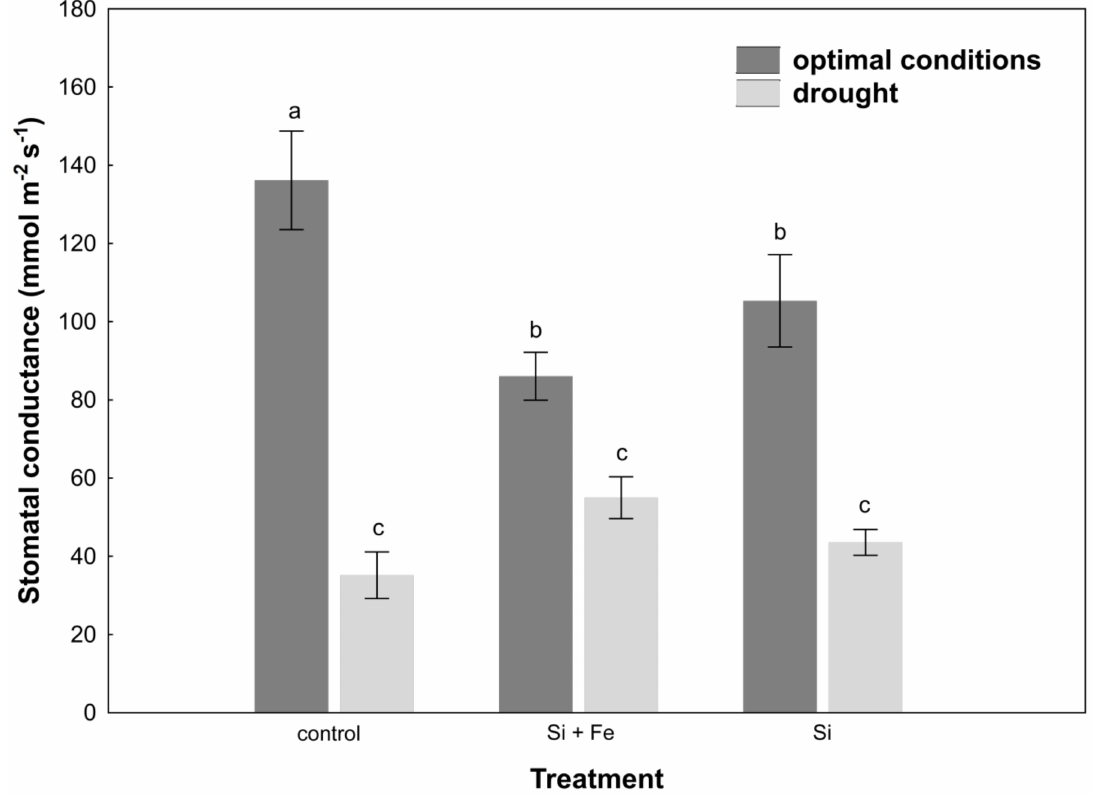
Figure 3. Stomatal conductance in leaves of oilseed rape. Plants grew first for 44 days under optimal conditions and were watered three times with water (control), silicon and iron (Si + Fe), or only silicon (Si), and afterwards for 10 days under optimal conditions or drought, after which stomatal conductance measurements were performed (Experiment 2). The means (n = 9) ± SD marked with the same letter do not differ significantly (Duncan’s multiple range test, p <